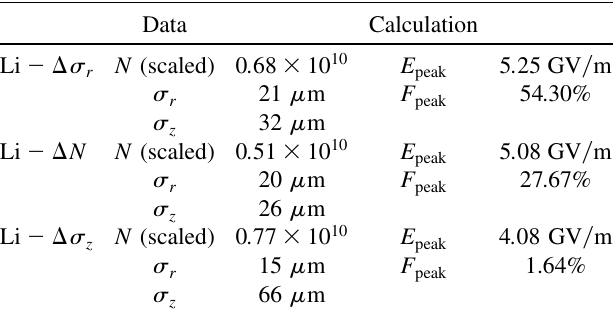
TABLE III. Lithium threshold conditions. Data